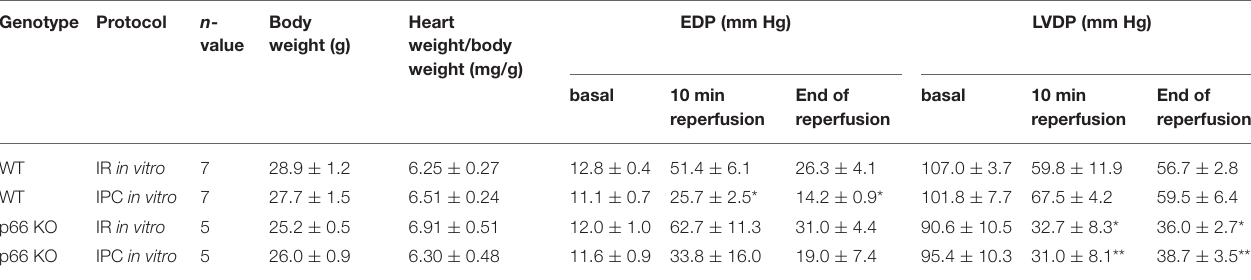
TABLE 1 | Summary of the baseline parameters and hemodynamic data throughout ischaemia-reperfusion protocols in vitro